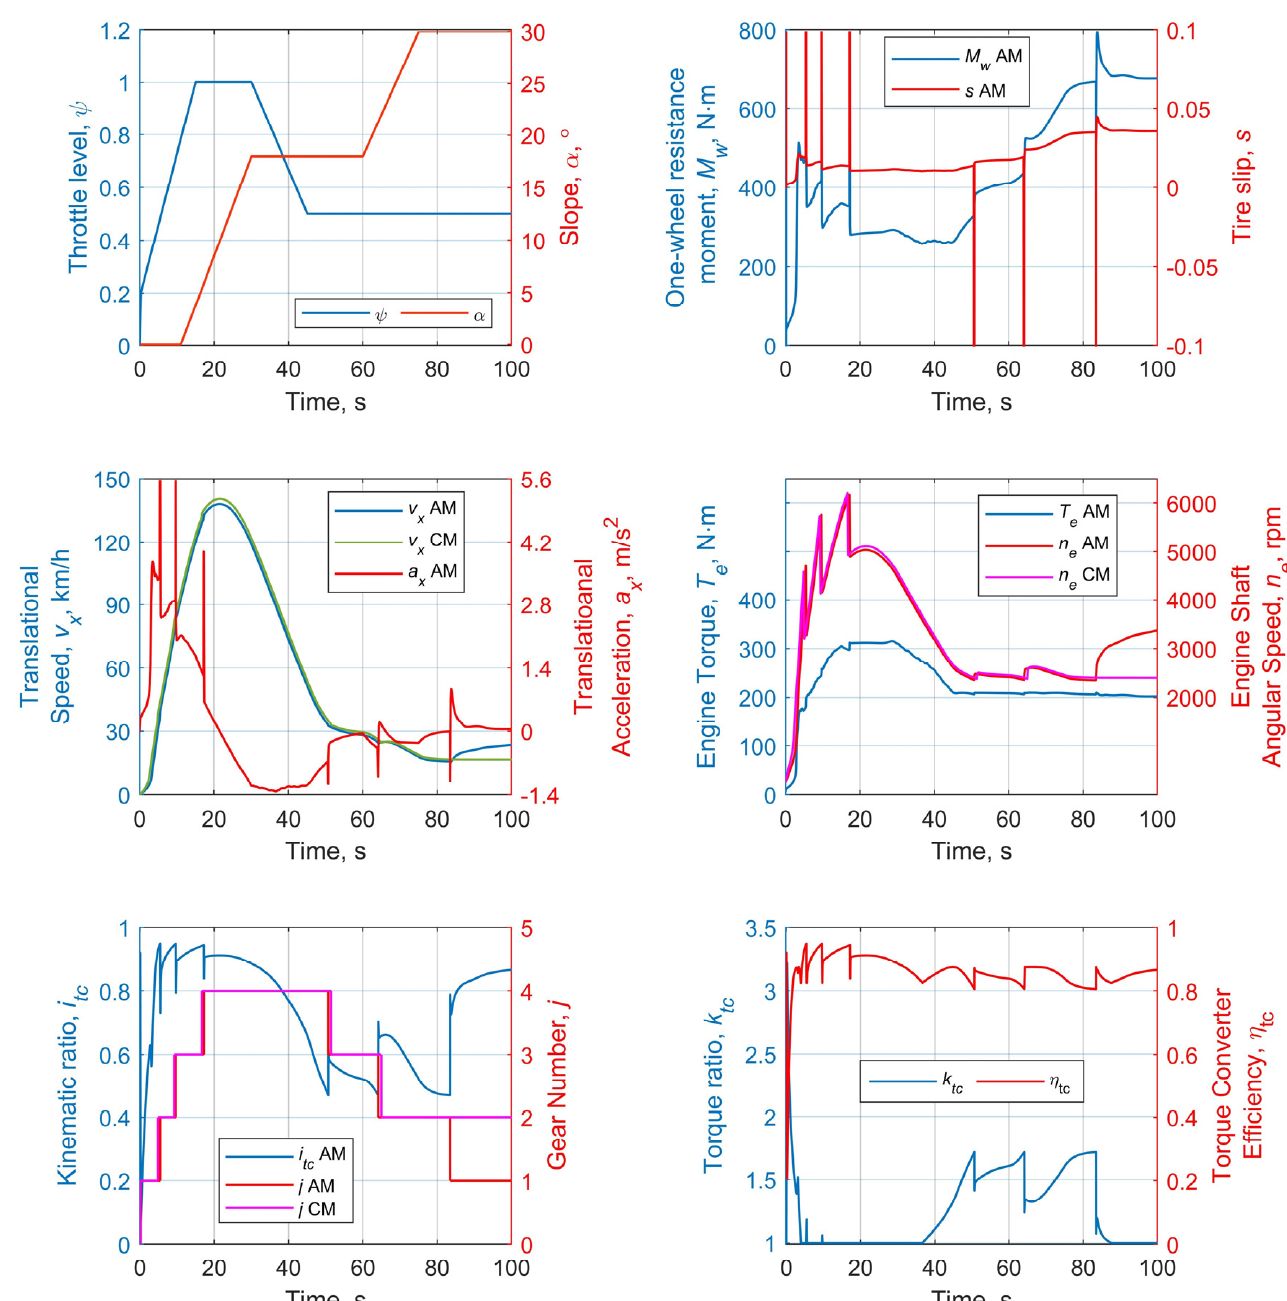
Figure 12. Simulation results for simultaneous variable accelerator level and variable load. The speed change nature entirely agrees with the combined factors of the control and load. The outputs of both models are identical in tendency, but with some